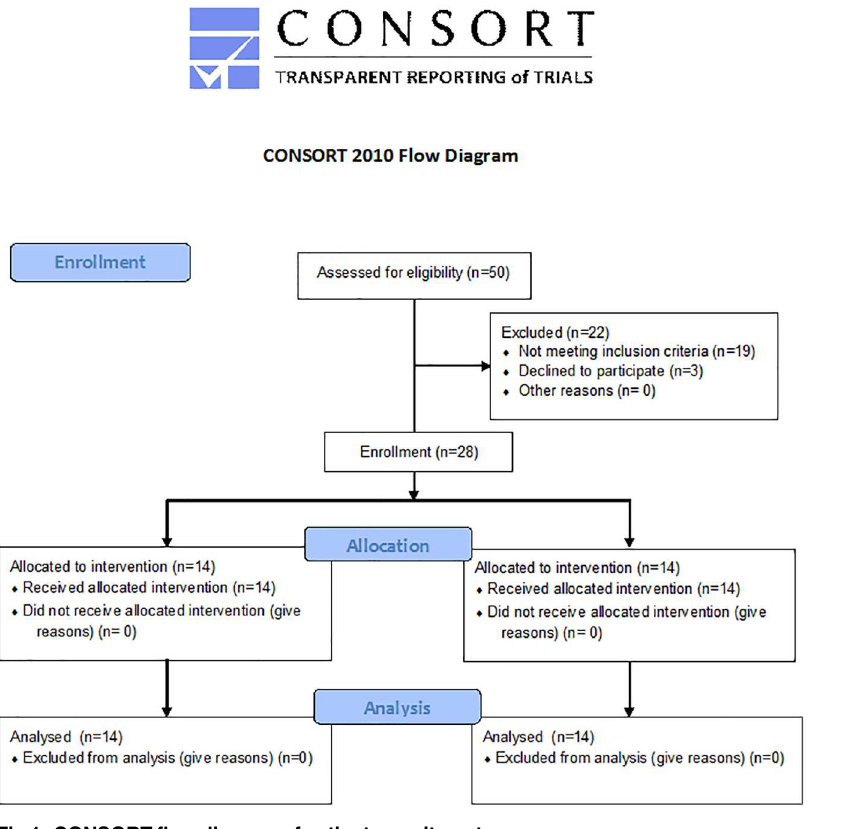
Fig 1. CONSORT flow diagram of patient recruitment.